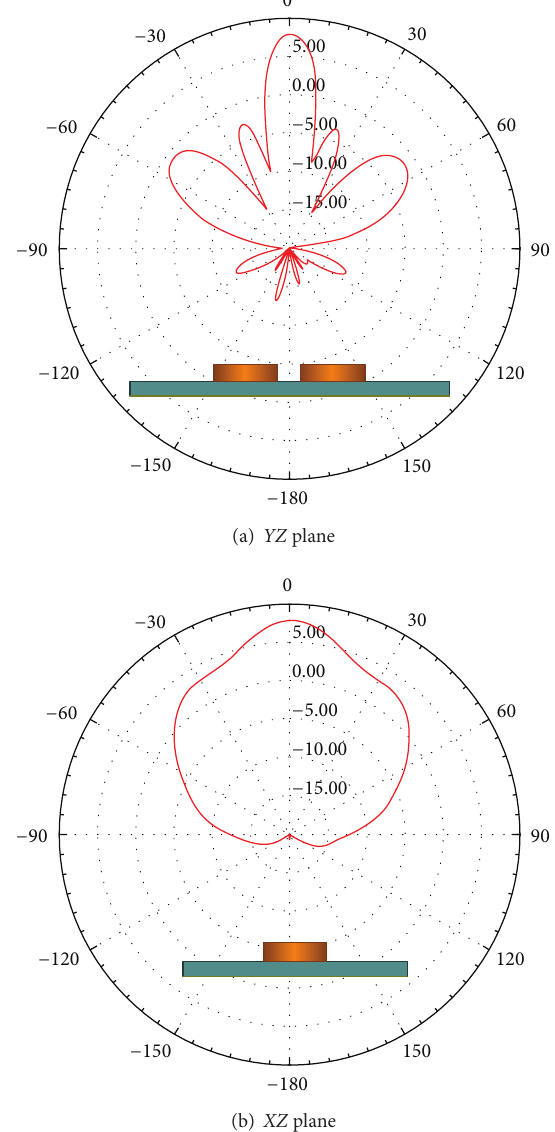
Figure 7: Simulated radiation pattern at 94 GHz. (a) YZ plane, (b) XZ plane, with 𝐿 1 = 14 mm, 𝑊 1 = 10mm, 𝐿 2 = 11.68mm, 𝑊 2 = = 13 𝜇 m, 𝑊 = 0.19 mm, 5.82 mm, 𝑆 off = 0.06 mm, 𝐶 𝐿 = 1mm, 𝐶 th 𝑊 𝐿 𝐺 = 20 𝜇 m, 𝐿 = 0.417 mm, 𝐶 off = 𝑠 = 0.75 mm, 𝑠 = 0.103mm, stub 0.16 mm, and 𝑃 𝑤 =